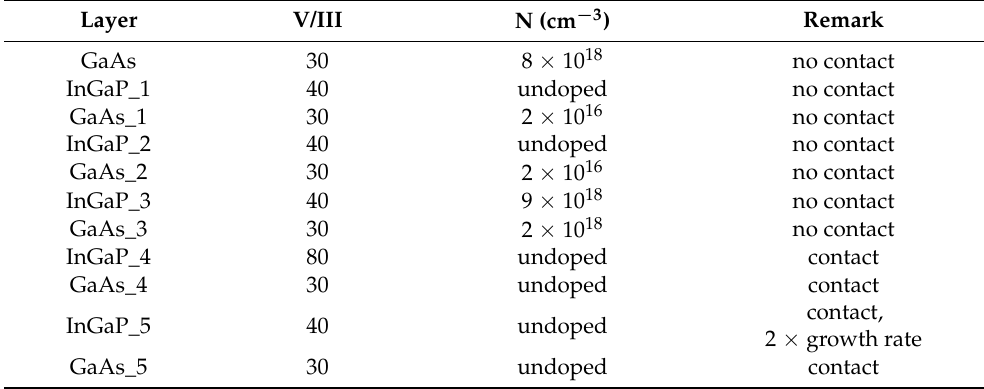
Table 1. Growth parameters of the layers in the 5 × GaAs/InGaP multilayer stack with TMIn/(TMIn